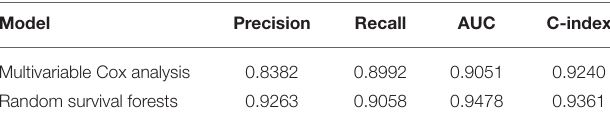
TABLE 4A | Performance comparisons between multivariable and random survival forest with five-fold cross